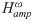
Examples illustrating our theory.Centre: Sample paths from the PF and CD models. In each of the three cases the x-axis denotes time and the y-axis number of activations. For each panel the middle trace denotes X′(t) and the top and bottom gωi(X′(t)). Left: DCCA correlation coefficients ρDCCA(n) and Hurst exponents Hampω. Right: Power-spectra of X′(t) in each of the three cases. We see that the top row displays qualitatively different properties to the middle and bottom rows, although the power-spectra are the same in each case. The differences are, however, well quantified by the Hurst exponent and ρDCCA(n) in the left-hand column. See Section: Results: Simulations: Examples.